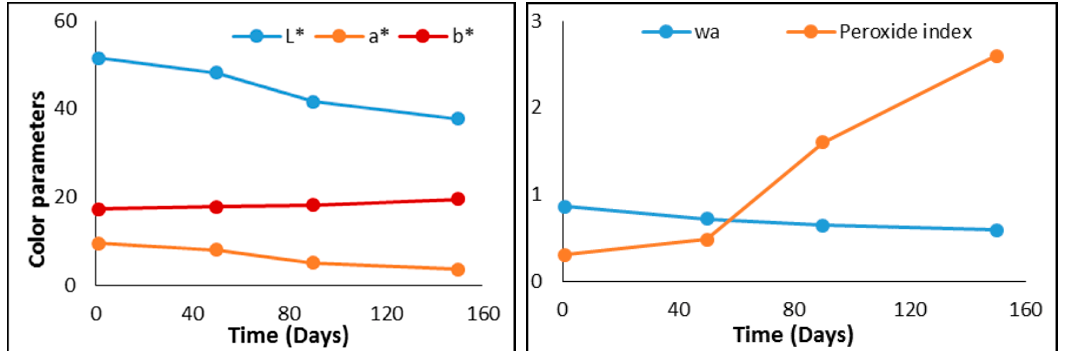
Figure 5. Evolution in time of analyzed parameters of prosciutto (peroxide index is expressed in meq O2/kg of samples).